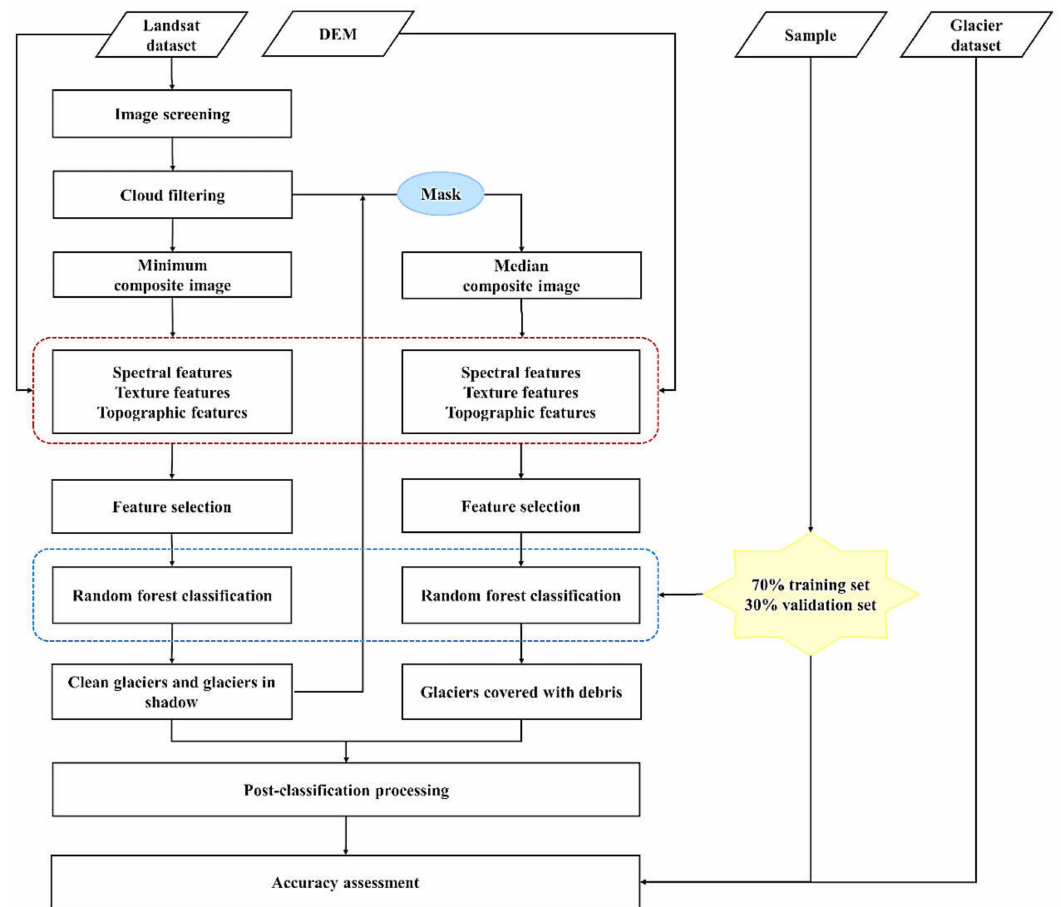
Figure 2. The process of glacier